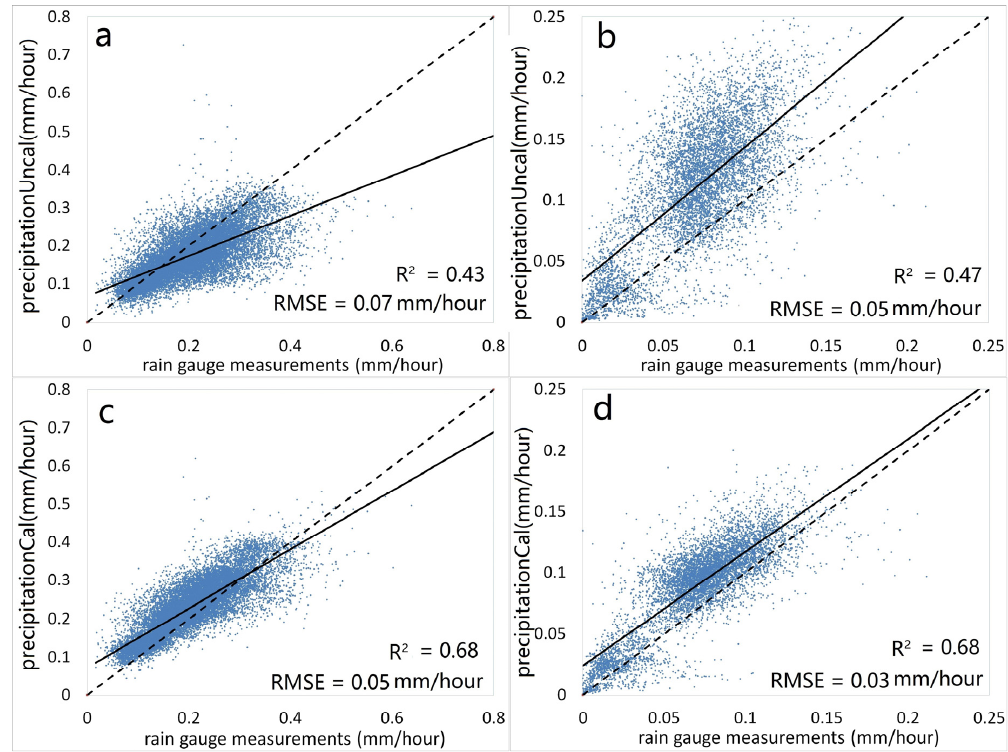
Figure 2. The spatial pattern of the hourly precipitation intensity measured by ( a ) rain gauge measurements; ( b ) un-calibrated Integrated Multi-satellite Retrievals for Global Precipitation Measurement (IMERG) (termed as precipitationUncal); ( c ) calibrated IMERG (termed as precipitationCal); ( d ) the comparison result of precipitationUncal and precipitationCal for each grid during April~October in 2014.